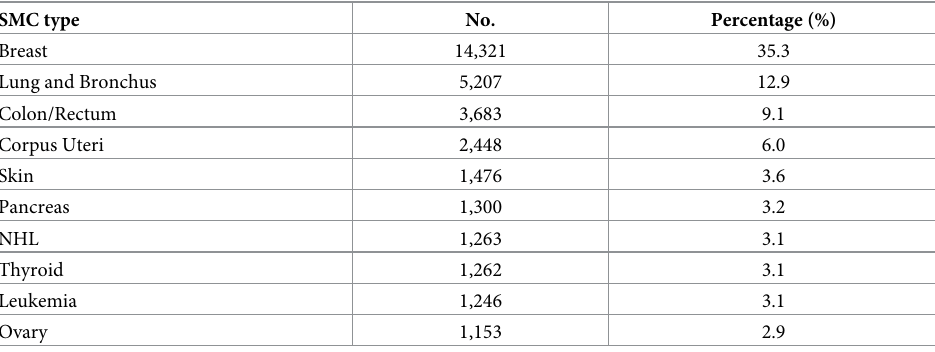
Table 1. The top ten types of second metachronous cancer (SMC) in breast cancer